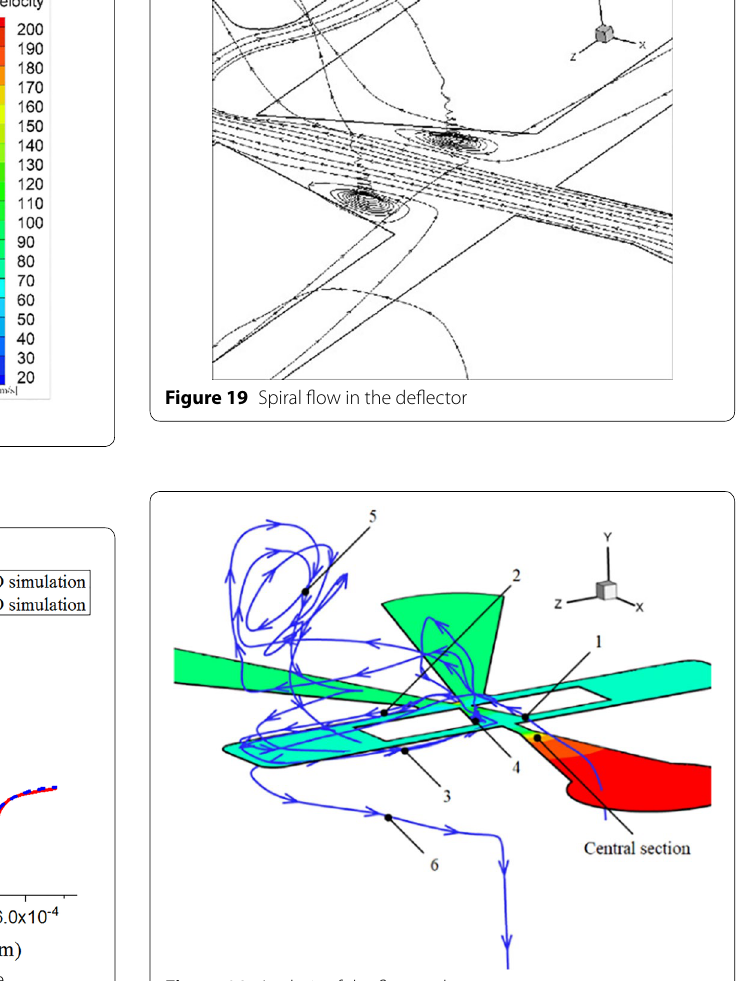
Figure 20 Analysis of the flow